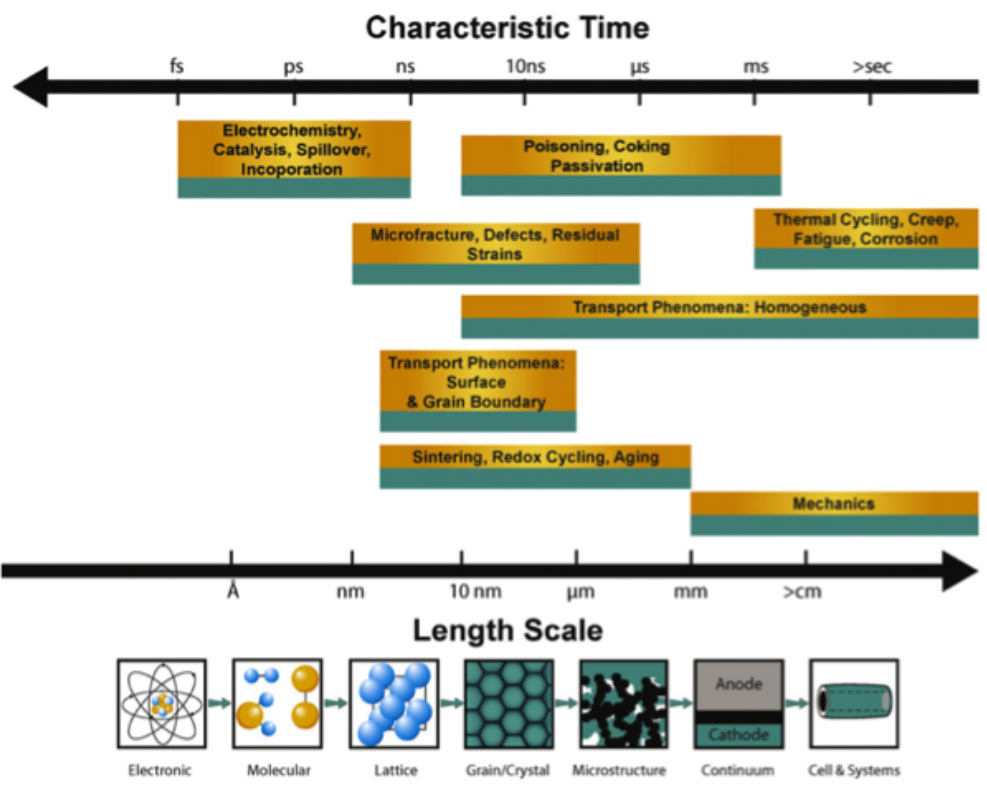
Figure 1. Different processes and their corresponding length scales and time frames during the operation of an SOFC (mathematical modelling takes all such processes into account) (figure reprinted from Grew et al. [21] Copyright (2012), with permission from Elsevier).